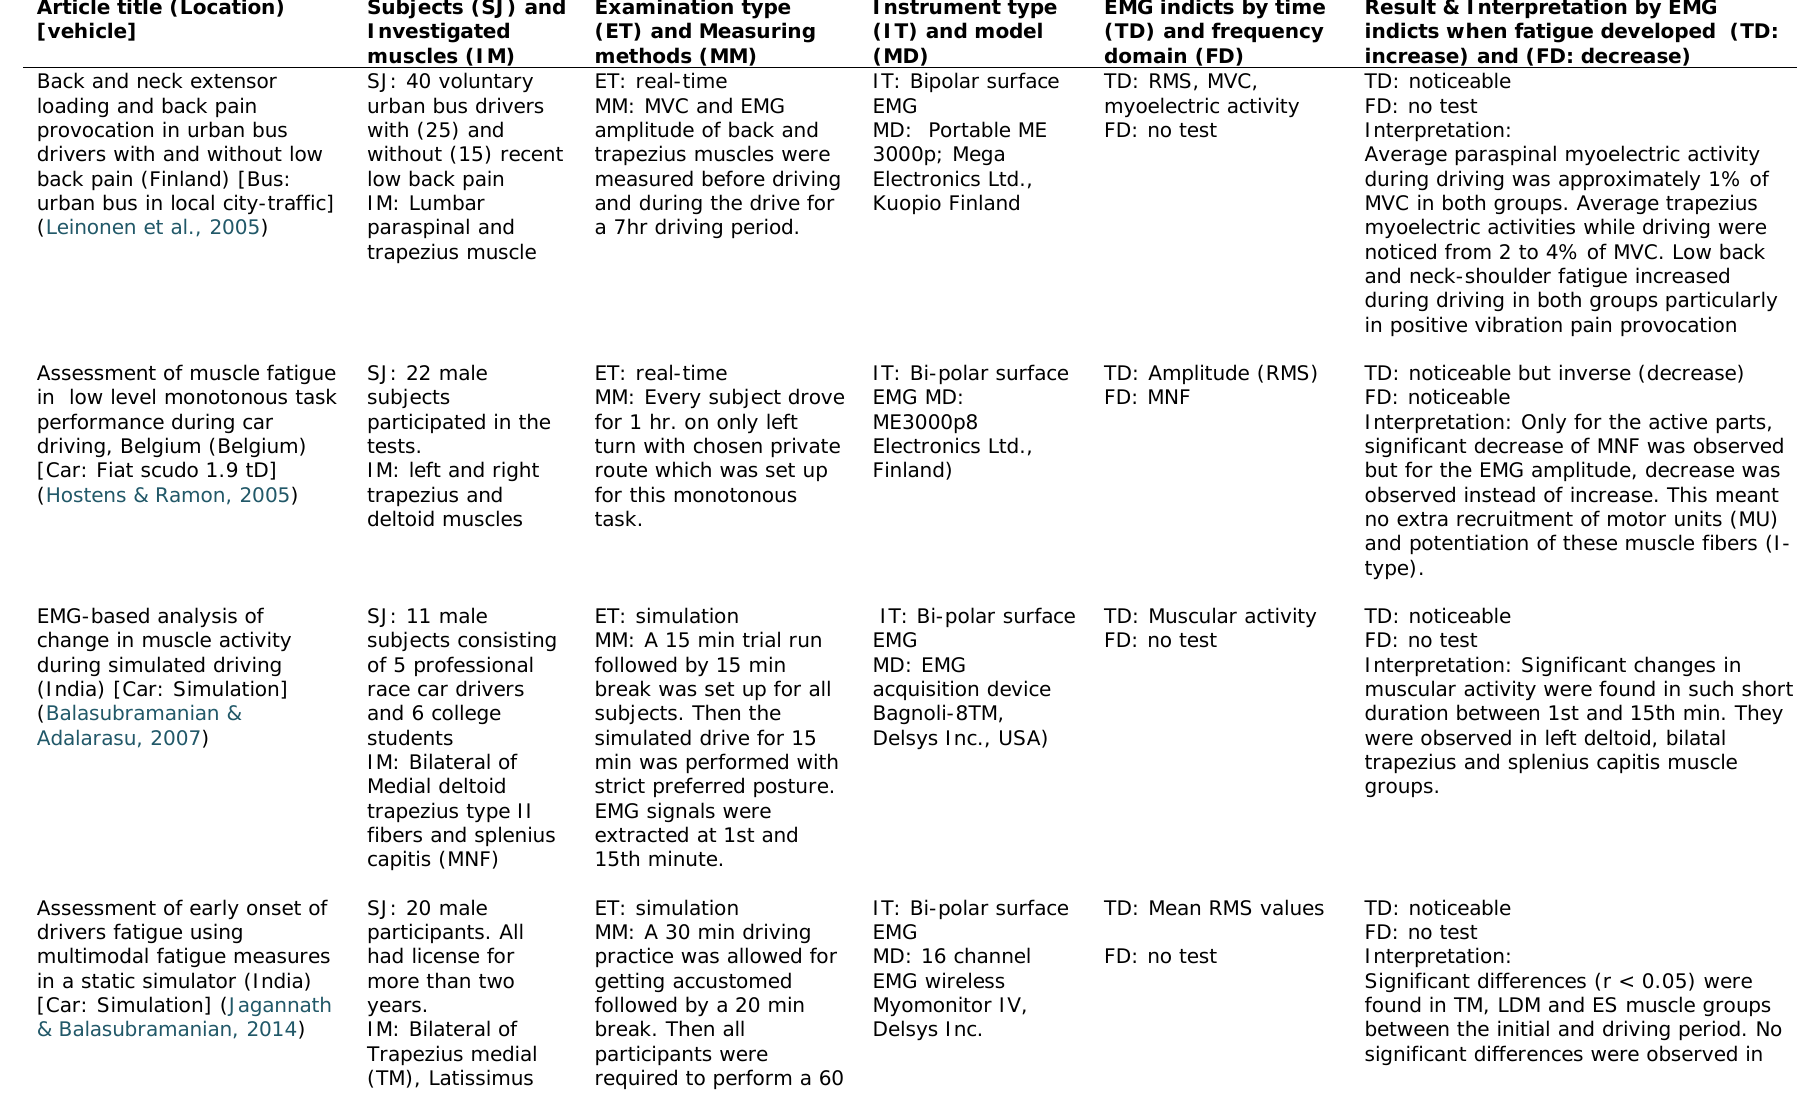
Article title (Location)